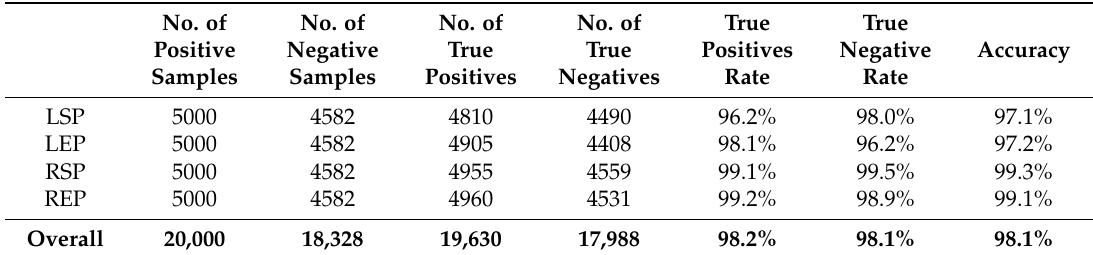
Table 3. Performance of the HOG-SVM-based lane endpoint verifier.